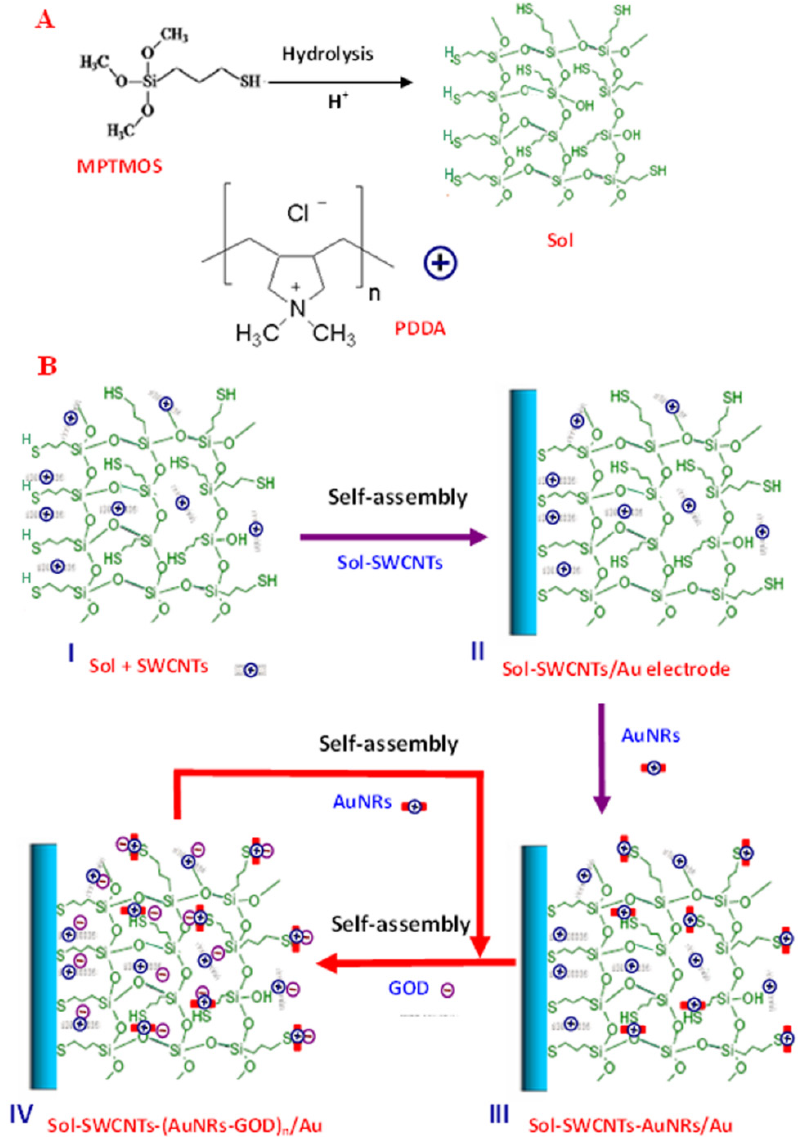
Figure 1. ( A ) Hydrolysis of (3-mercaptopropyl) trimethoxy silane (MPTMOS) and the molecular structure of Poly(diallyldimethylammonium chloride) (PDDA); ( B ) The stepwise fabrication process of the biosensor based on stereo self-assembling gold nanorods (AuNRs) and glucose oxidase (GOD) to single-walled carbon nanotubes (SWCNTs) functionalized three-dimensional sol-gel matrix.